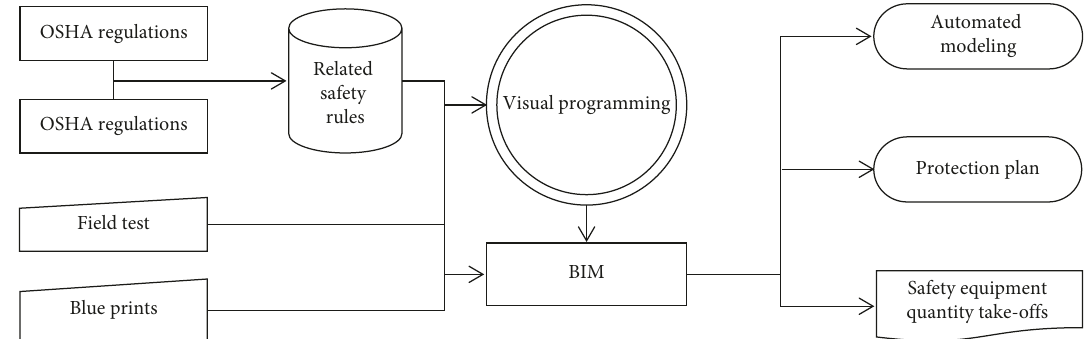
Figure 1: Conceptual framework for automated safety excavation modeling